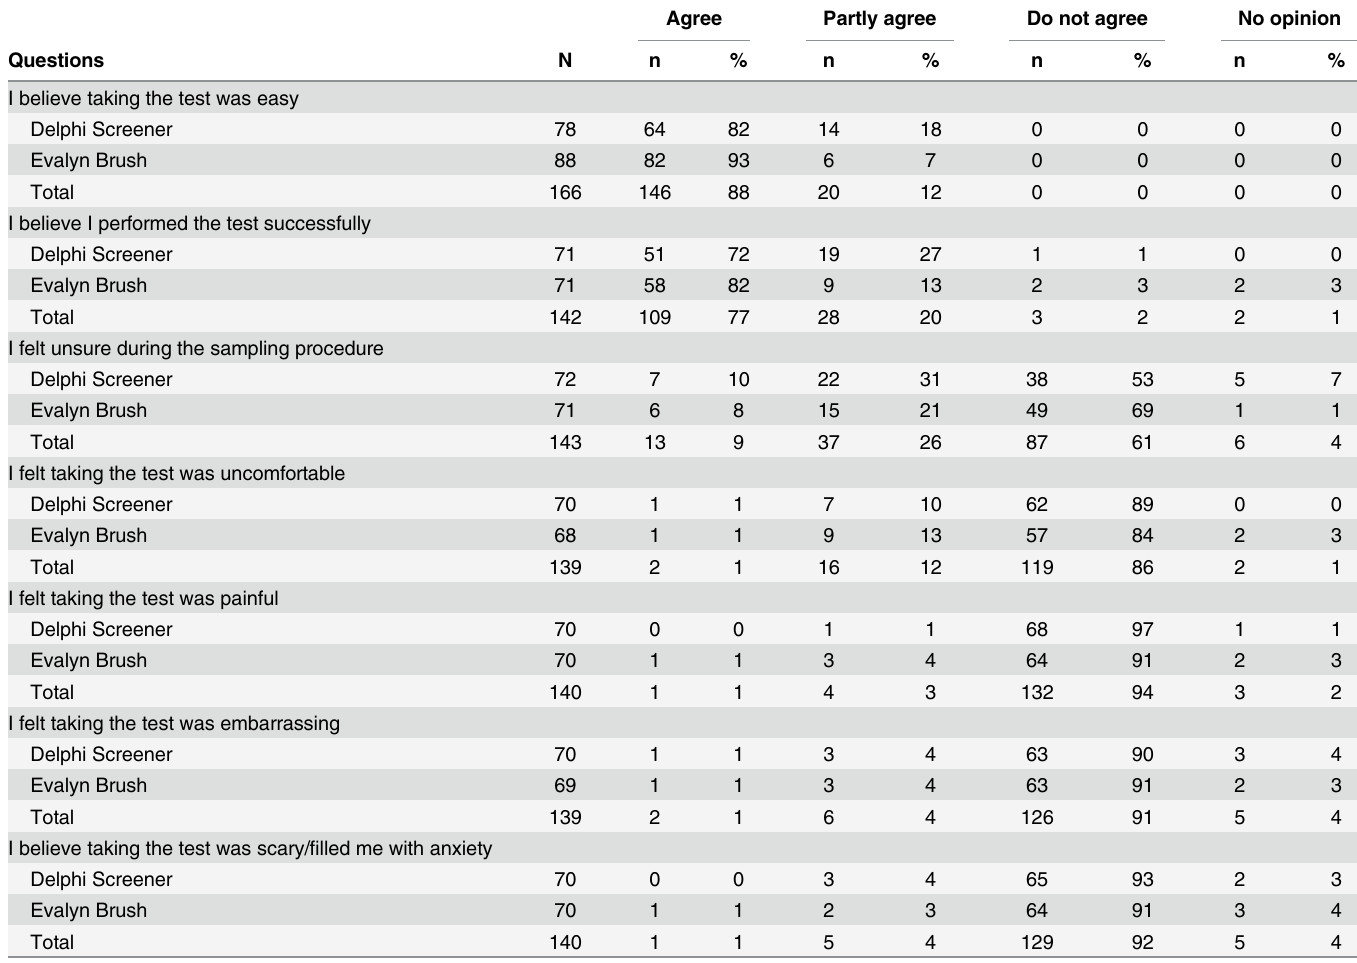
Table 4. Self-sampling experience taken from the